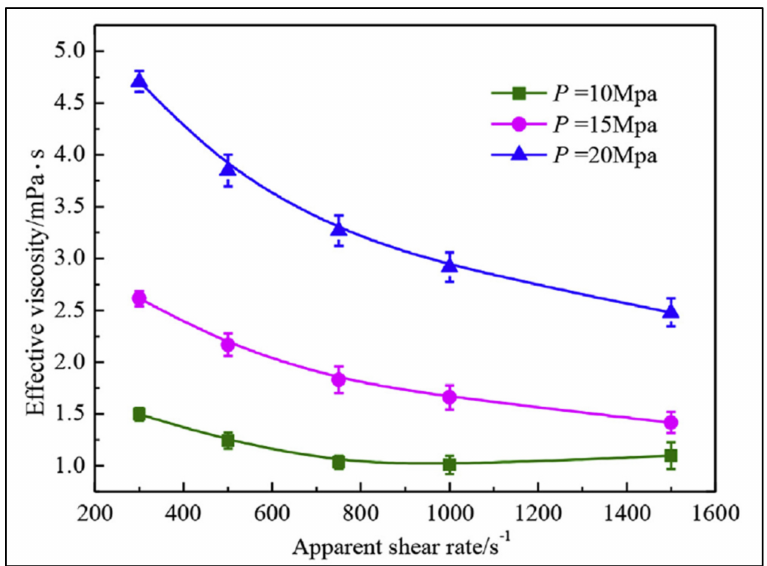
Figure 7. The effect of pressure on foam effective viscosity (Reprinted with permission from Jing et al. [53]). Copyright 2019, Elsevier